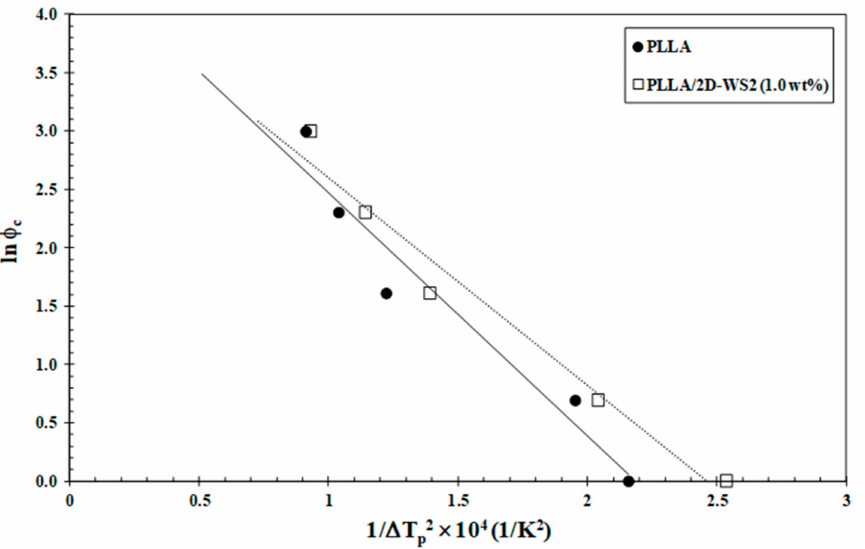
Figure 11. Dobreva plots for evaluating nucleation activity of 2D-WS 2 in PLLA/2D-WS 2 (1.0 wt%)